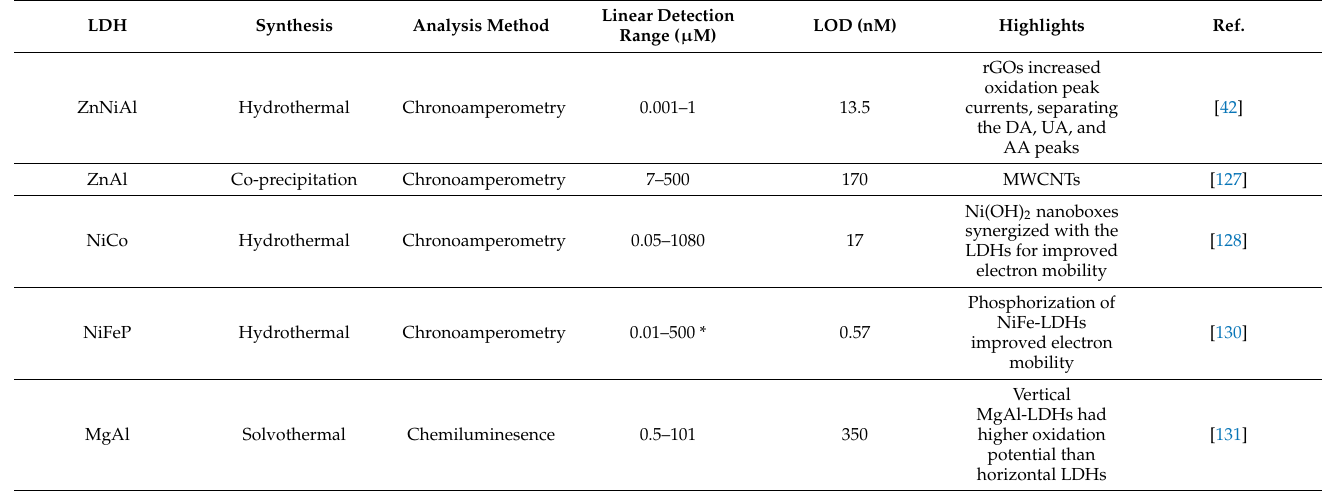
Table 2. The detection performance of LDH-based dopamine